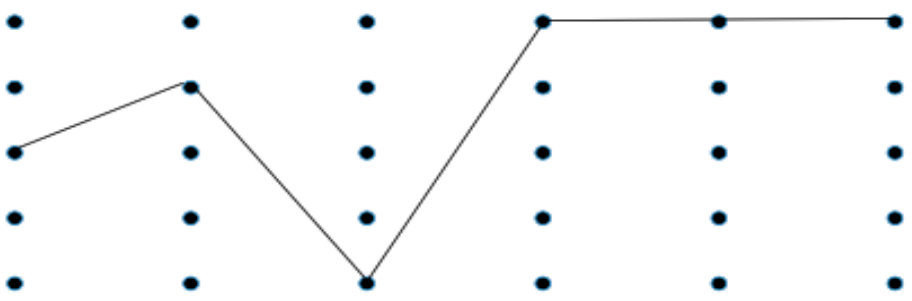
Figure 3. The next combination of renewable energy sources (RES) project options in case of the unacceptability of the previous one.